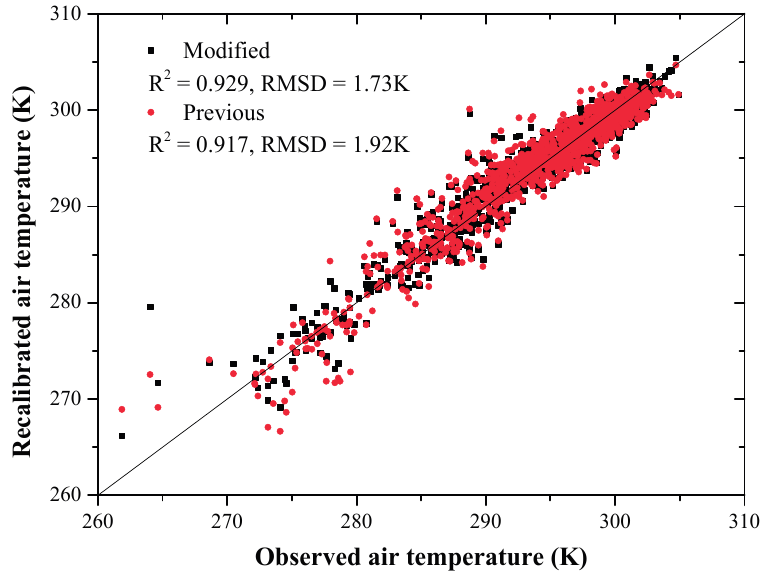
Figure 2. Comparison between the observed air temperature and the fitted air temperature before and after the modification on the calibration method (Equation